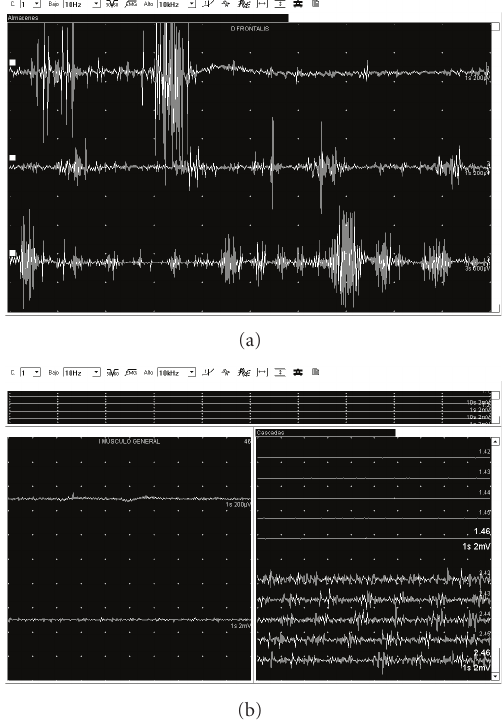
Figure 1: EMG recording a semirhythmic tremor in right frontalis muscle. (a) 5-6 Hz tremor (Patient 2) with patient speaking. (b) 6Hz tremor (Patient 3) with patient speaking.